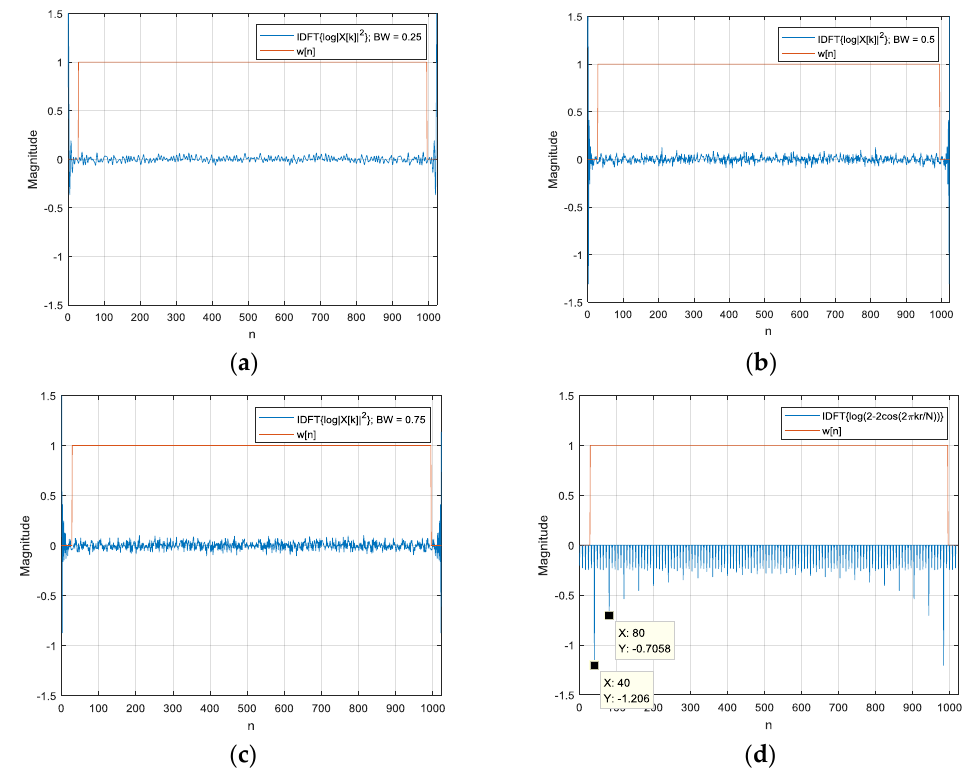
Figure 3. The signal portion IDFT { log | X [ k ] | 2 } for the ( a ) 0.25, ( b ) 0.5 and ( c ) 0.75 normalized frequency bandwidths and ( d ) the delay part log ( 2 − 2cos ( 2 π k ( r 2 − r 1 ) / N )) for 40 sample delays.